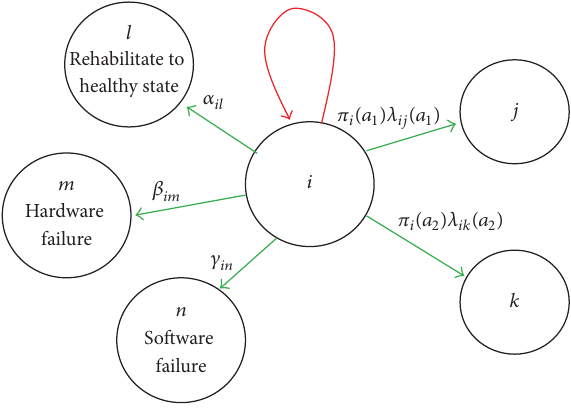
Figure 5: Stochastic process containing both security and depend- ability